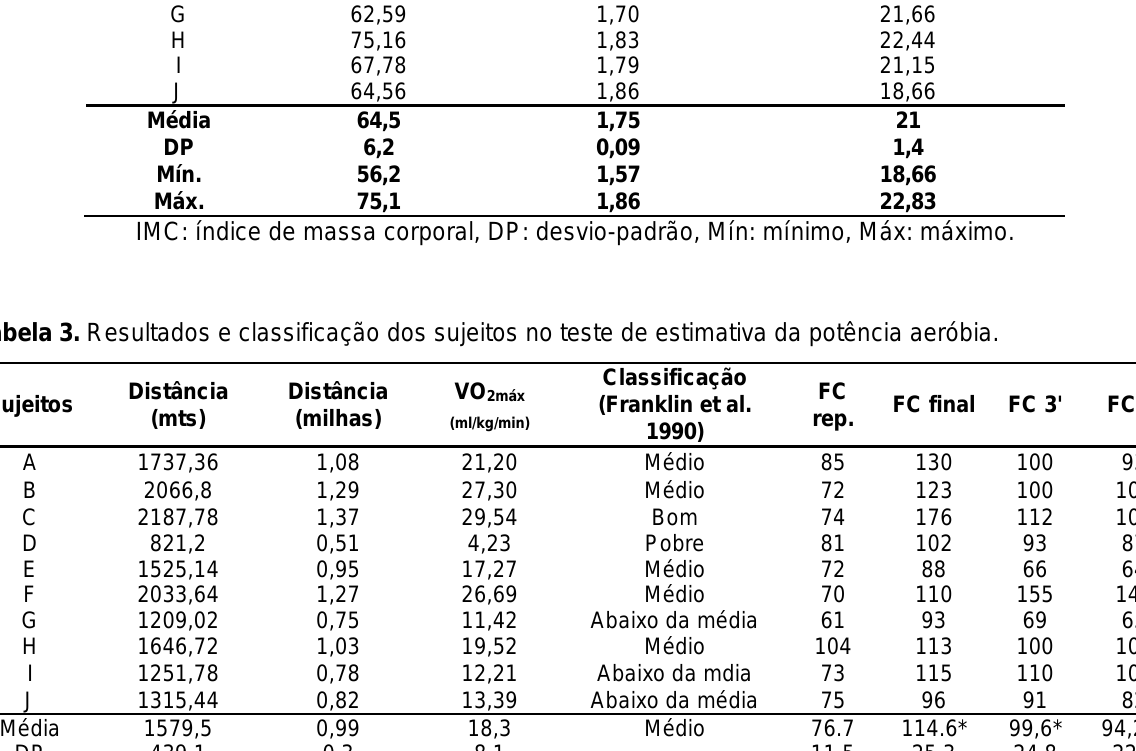
FC: frequência cardíaca em bpm, FC3: frequência cardíaca após três minutos de recuperação, FC5: frequência cardíaca após cinco minutos de recuperação. *p<0,05 vs repouso, # p<0,05 vs